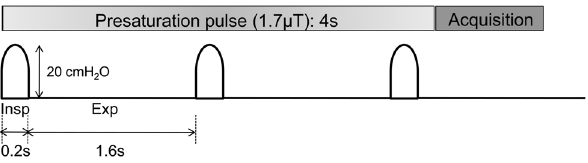
Figure 1. Study design for APT imaging of the mice lung using the small animal ventilator. The animal was mechanically